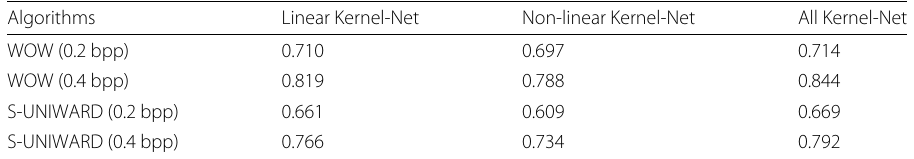
Table 3 The performance of Linear Kernel-Net, Non-linear Kernel-Net, and All Kernel-Net on resampled images Algorithms Linear Kernel-Net Non-linear Kernel-Net All Kernel-Net WOW (0.2 bpp) 0.710 0.697 0.714 WOW (0.4 bpp) 0.819 0.788 0.844 S-UNIWARD (0.2 bpp) 0.661 0.609 0.669